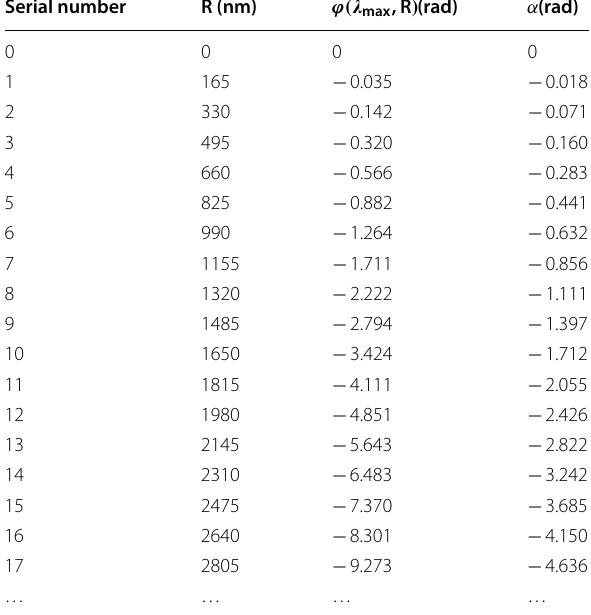
Table 1 Fixed phase control